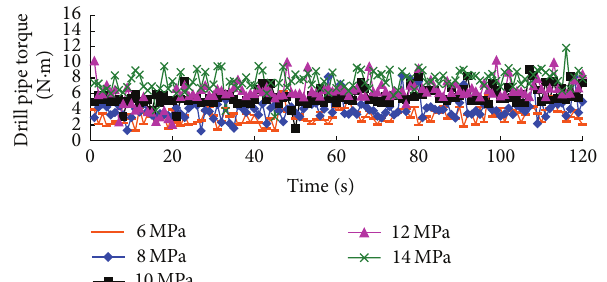
Figure 6: Time history curve of drill pipe torque under different coal